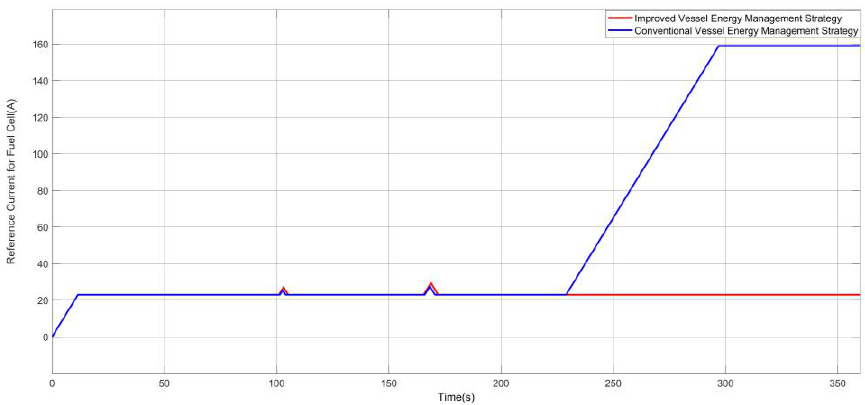
Figure 22. FC reference current curve.